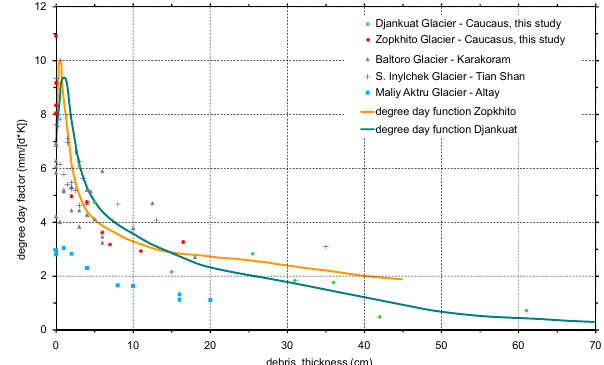
Fig. 9. Degree day factor versus debris thicknesses for the stakes with approved ablation measurements on the Zopkhito Glacier dur- ing the observation periods. The maximum ablation is reached for very thin debris layers.